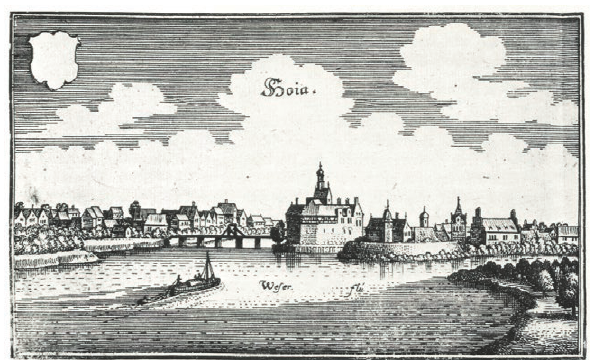
Figure 3. Stamp issued in honour of Beckmann in1989 by the for- mer German Democratic